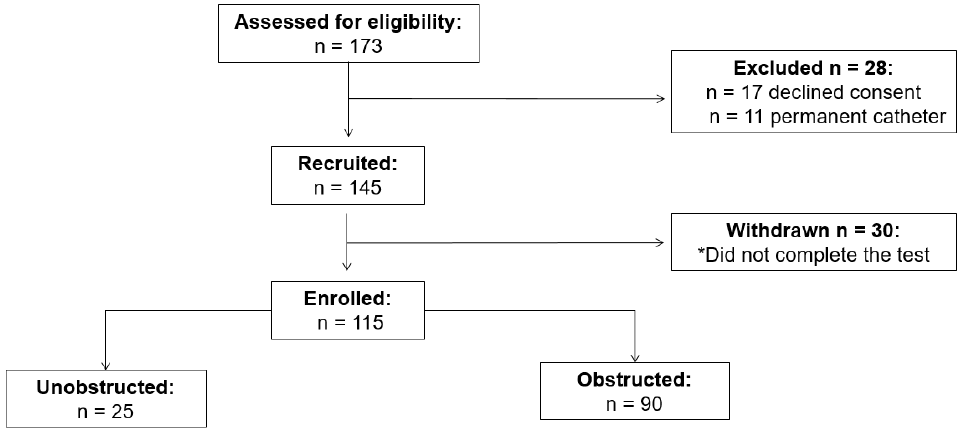
Figure 1. CONSORT diagram—flow of participants through trial phases. * Due to inability to insert the urethral probe or inability to void with the urethral catheter in place.